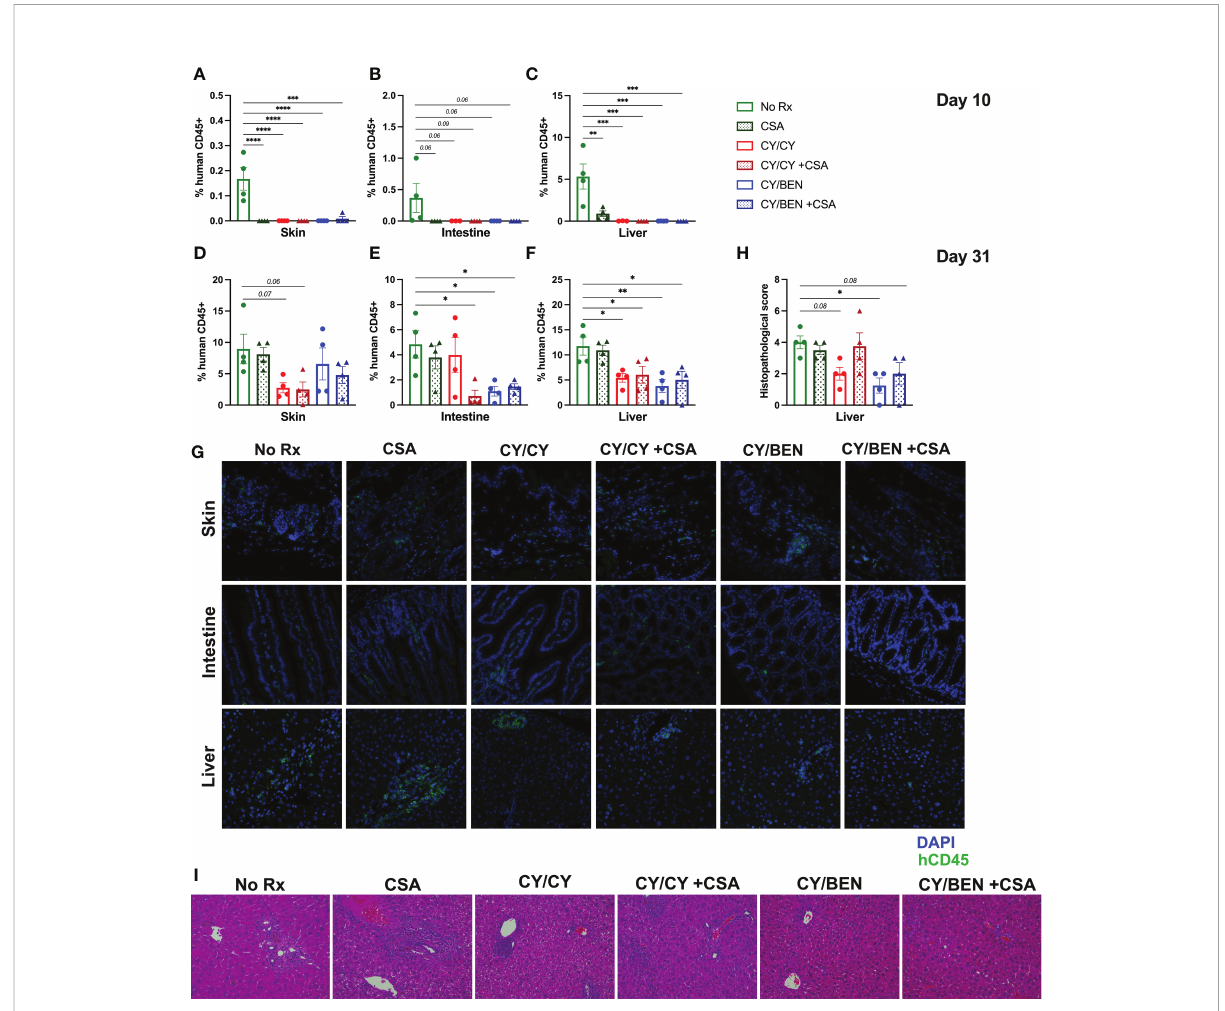
FIGURE 5 Histopathological alterations and human immune cell in fi ltration of GvHD target organs is reduced at days 10 and 31 with post-PBMC chemotherapy use with or without the addition of CSA. (A-G) Immunohistochemistry of human CD45+ cells in skin, intestine and liver sections from mice in each treatment group was performed at (A-C) day 10 and (D-G) day 31 post-PBMC infusion to evaluate the extent of immune in fi ltration of GvHD target organs. (A-F) Average percent of human CD45+ cells out of the total cell number in (A, D) skin, (B, E) intestine and (C, F) liver. (G) Representative images of tissues from animals in each treatment group at day 31. (H, I) Liver tissue sections were stained with hematoxylin and eosin and scored blindly by a board-certi fi ed pathologist for GvHD-related lesions. (H) Average scores of liver lesions per treatment group. (I) Representative images of liver sections from animals in each treatment group. (A-F, H) Signi fi cant differences from no Rx was evaluated using a one-way ANOVA and Dunnett ’ s post-hoc comparisons with P values indicated by the number of asterisks between groups noted on graphs, *<0.05, **<0.01, ***<0.001,